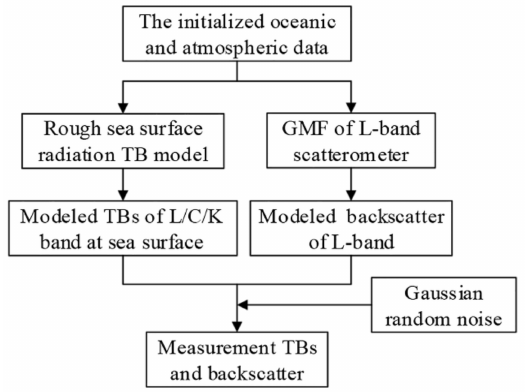
Figure 3. The simplified flow chart of the simulation process for measurements of